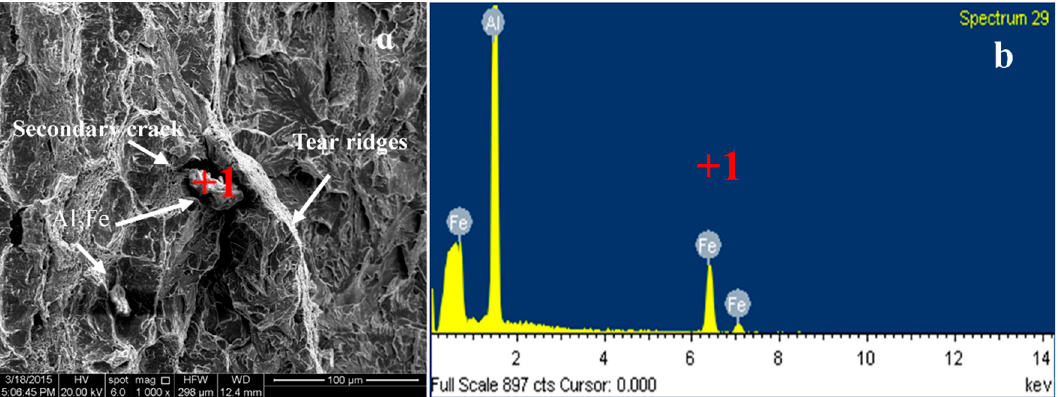
Figure 8. SEM image ( a ) and EDS analysis ( b ) of the alloy.